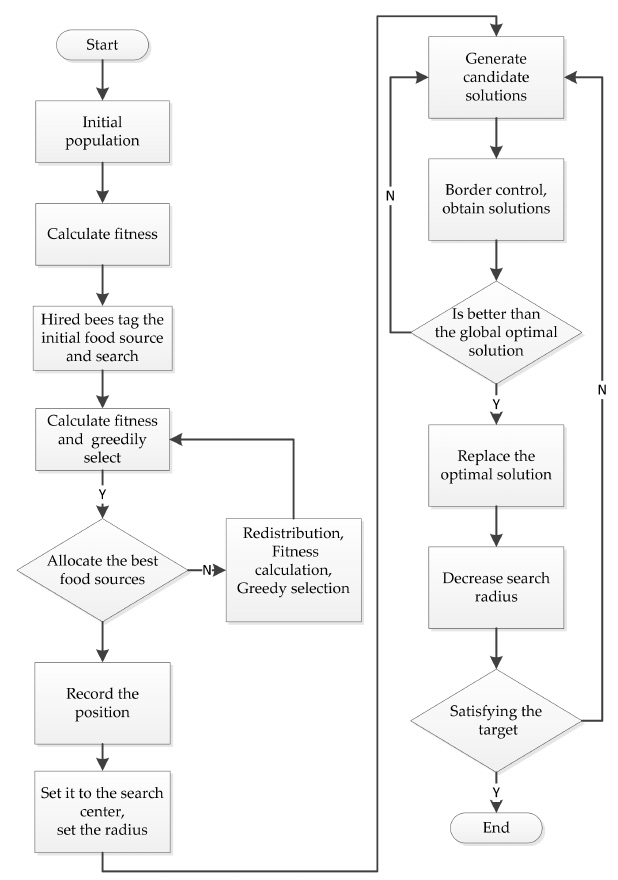
Figure 5. The flow chart of hybrid VS–ABC